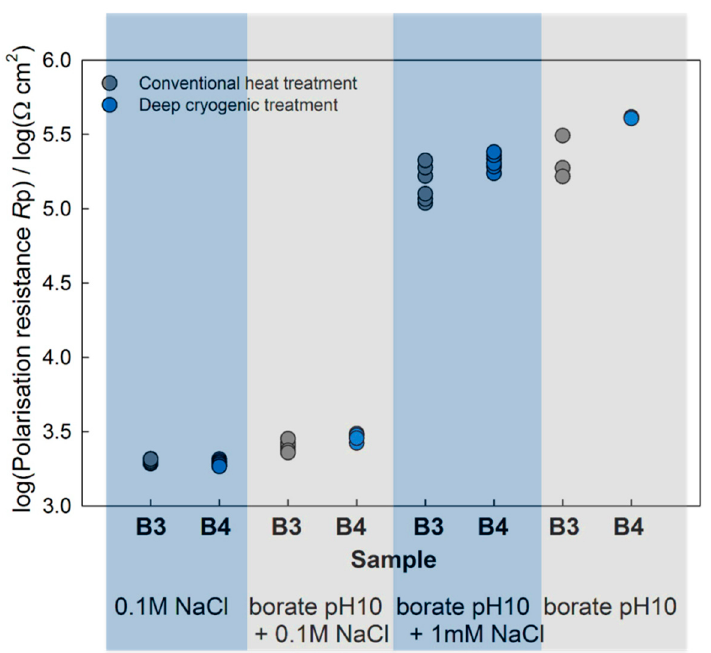
Figure A1. Scatter diagram of measurements on steel grade B in different aqueous solutions.